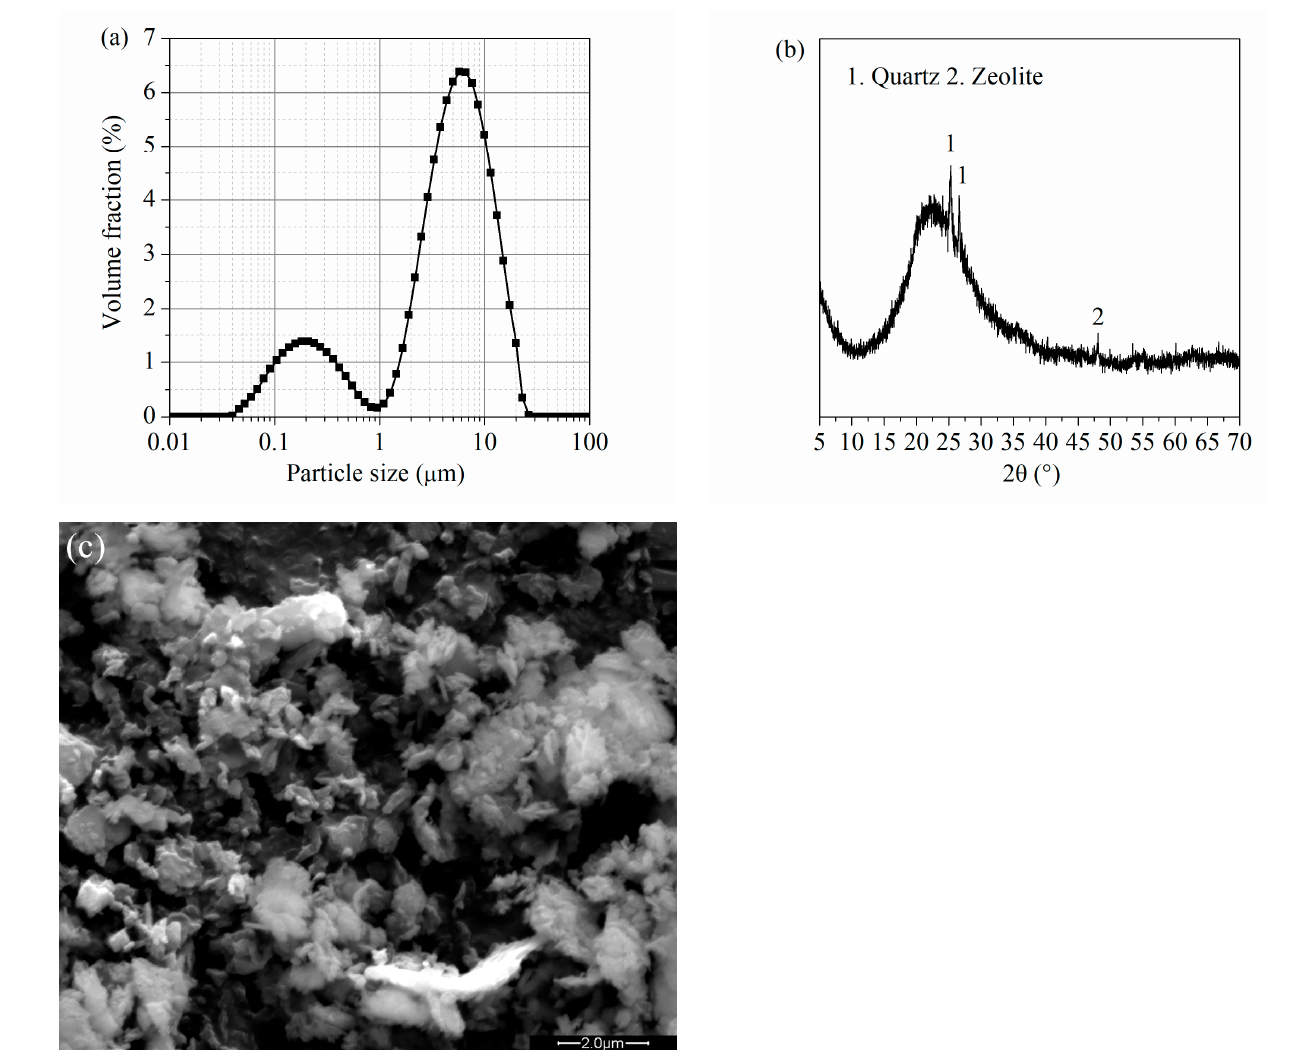
Figure 1. Characteristics of ultrafine metakaolin used in this study: ( a ) particle size distribution; ( b ) XRD analysis; ( c ) micromorphology .